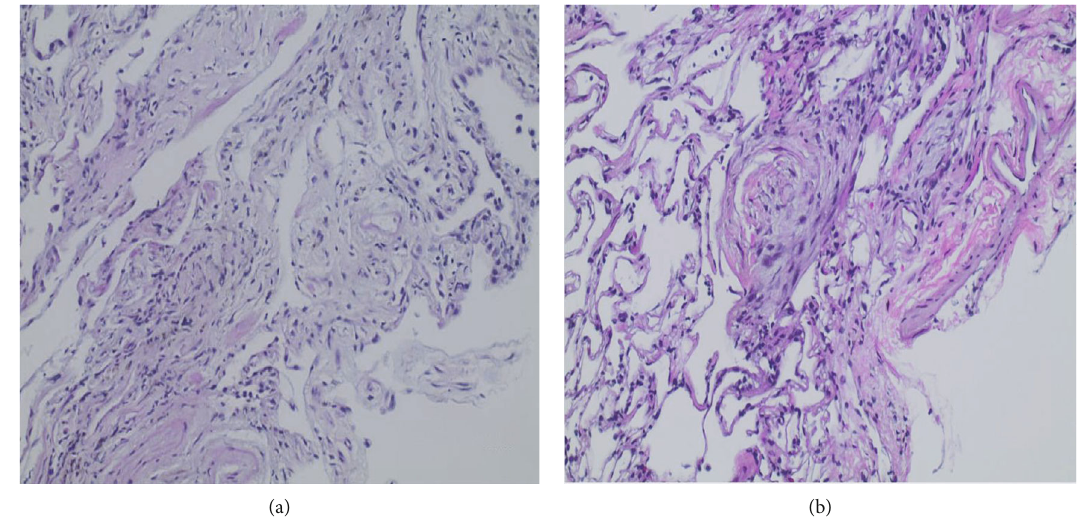
Figure 6: (a) Case 1. Patchy interstitial fi brosis, pigmented macrophages, lymphocytes, and rare eosinophils consistent with PLCH. (b) Fibromyxoid foci (Masson bodies) and fi brosis with sparse lymphoid in fi ltrate compatible with HP.